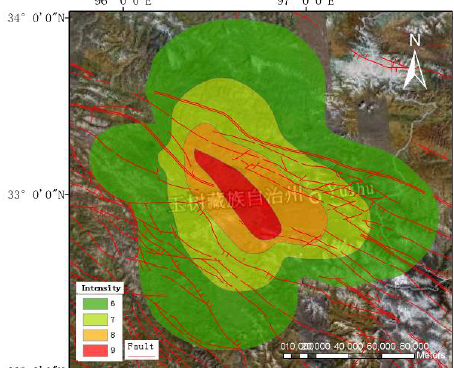
Figure 5 Fault trace and seismic intensity map of Yushu Earthquake